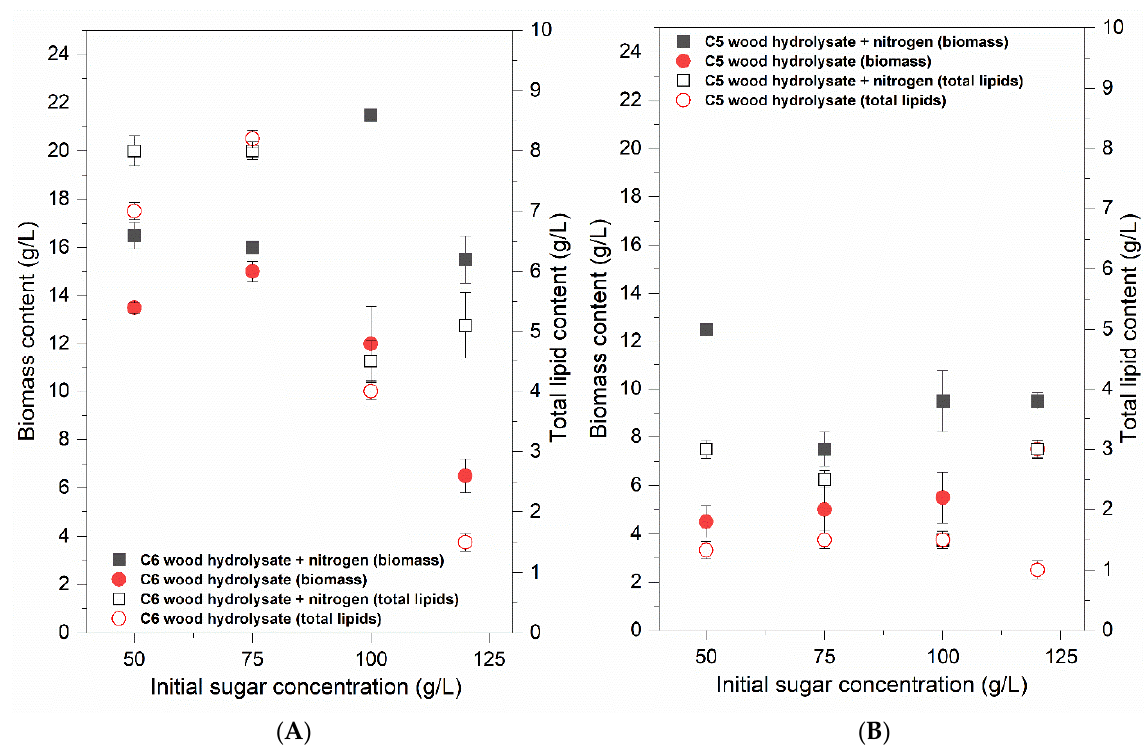
Figure 4. Lipid accumulation profile by R. toruloides -1588 using wood hydrolysate as a culture media. ( A ) C6 hydrolysate; ( B ) C5 hydrolysate. Table 2. Performance of R. toruloides -1588 using C5 and C6 hydrolysates as a culture